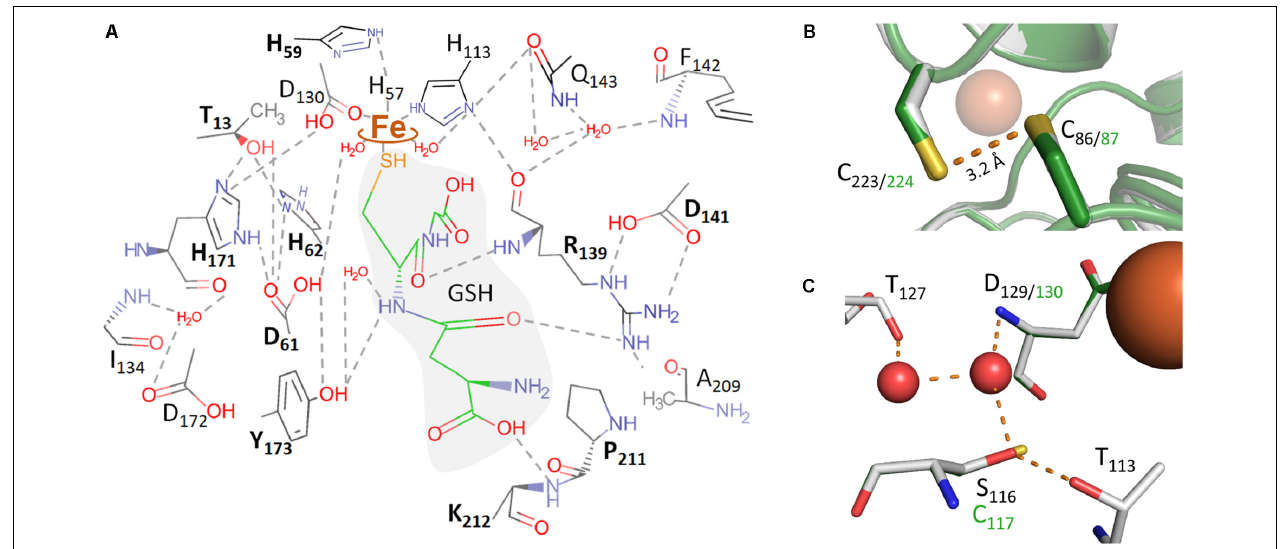
FIGURE 5 | Molecular representations of the Ac PDO 3D model with glutathione from the Pp PDO structure (5VE5). (A) Theoretical model of GSH in the Ac PDO active site structure and predicted hydrogen bonds; boldface amino acid residues were mutagenized in this study. (B) C 86 and C 223 in the Mx PDO 3D structure (gray) and in the Ac PDO model (green). (C) Comparison of the secondary coordination sphere around D 129 / 130 between the Mx PDO (gray) and the Ac PDO (green) originating from the S 116 residue in the Mx PDO.